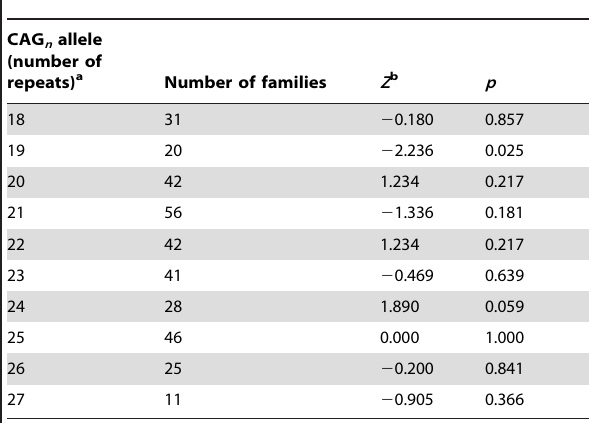
Table 6. FBAT analysis of the AR CAG n polymorphism under the dominant model in mother-father-preterm offspring trios of the initial SPTB case